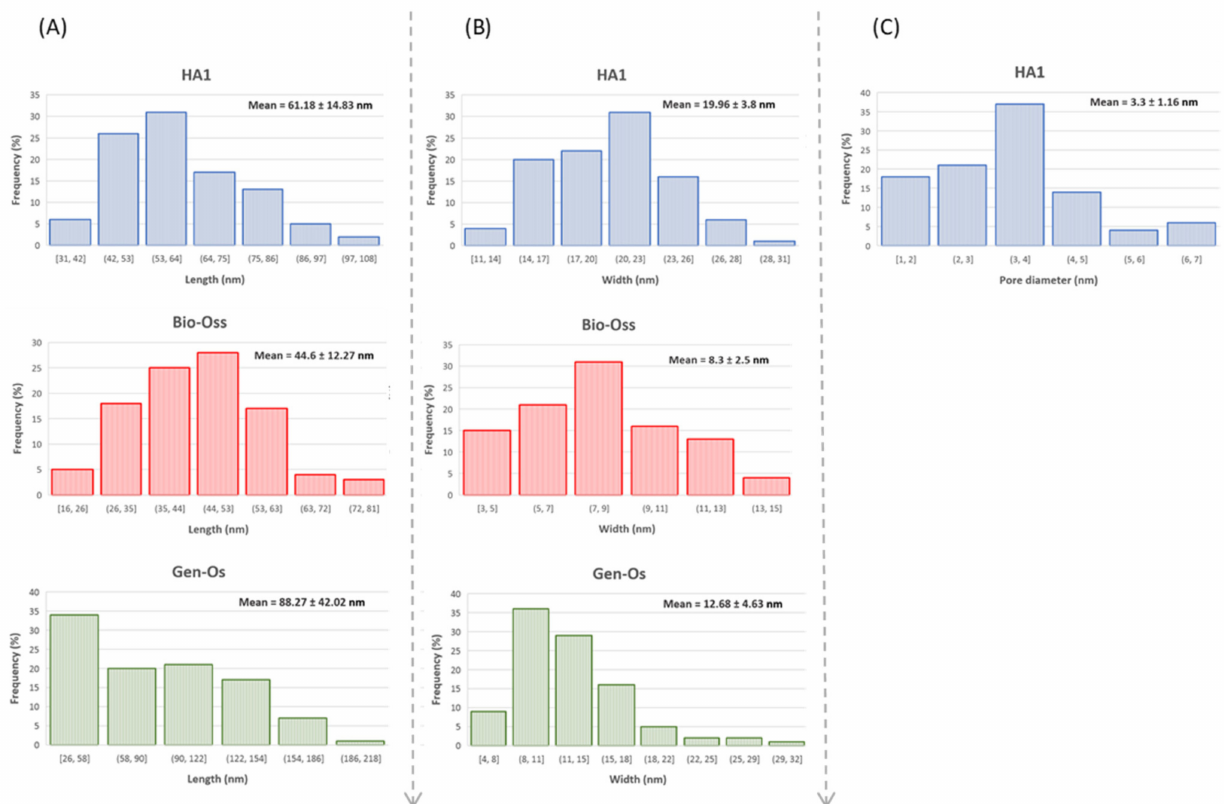
Figure 6. HA1 (blue), Bio-Oss (red), Gen-Os (green) particles length distribution ( A ) and width distribution ( B ); internal pores size distribution for HA1 sample ( C ).